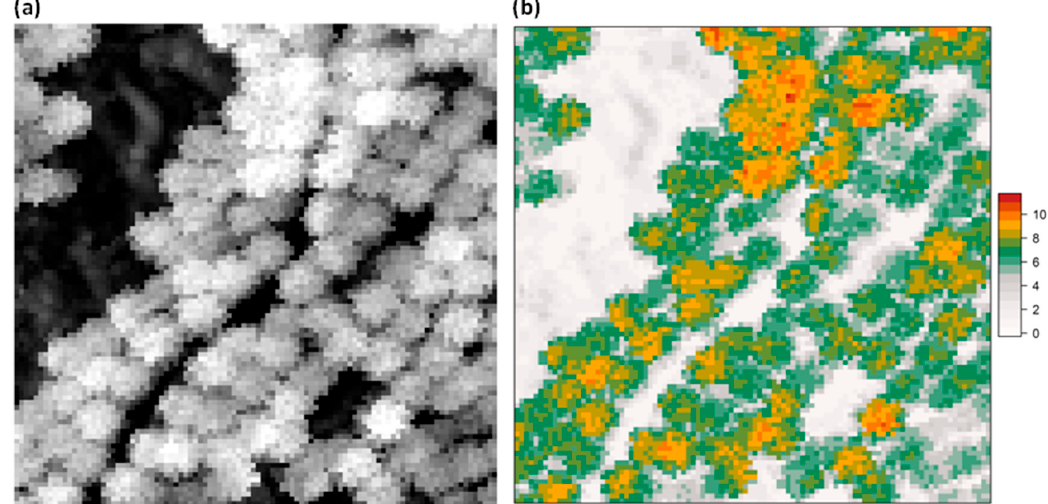
Figure 3. ( a ) A monochromatic image from the Pléiades satellite constellation and ( b ) an airborne LiDAR image of a 1-ha plot to show a typical oil palm plantation canopy. The legend refers to height in metres of individual palms displayed on the LiDAR image.